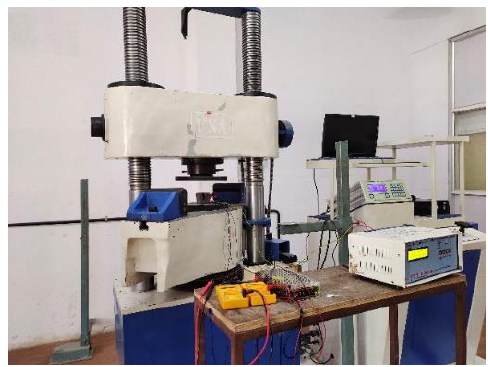
Figure 6. Testing of cubes.